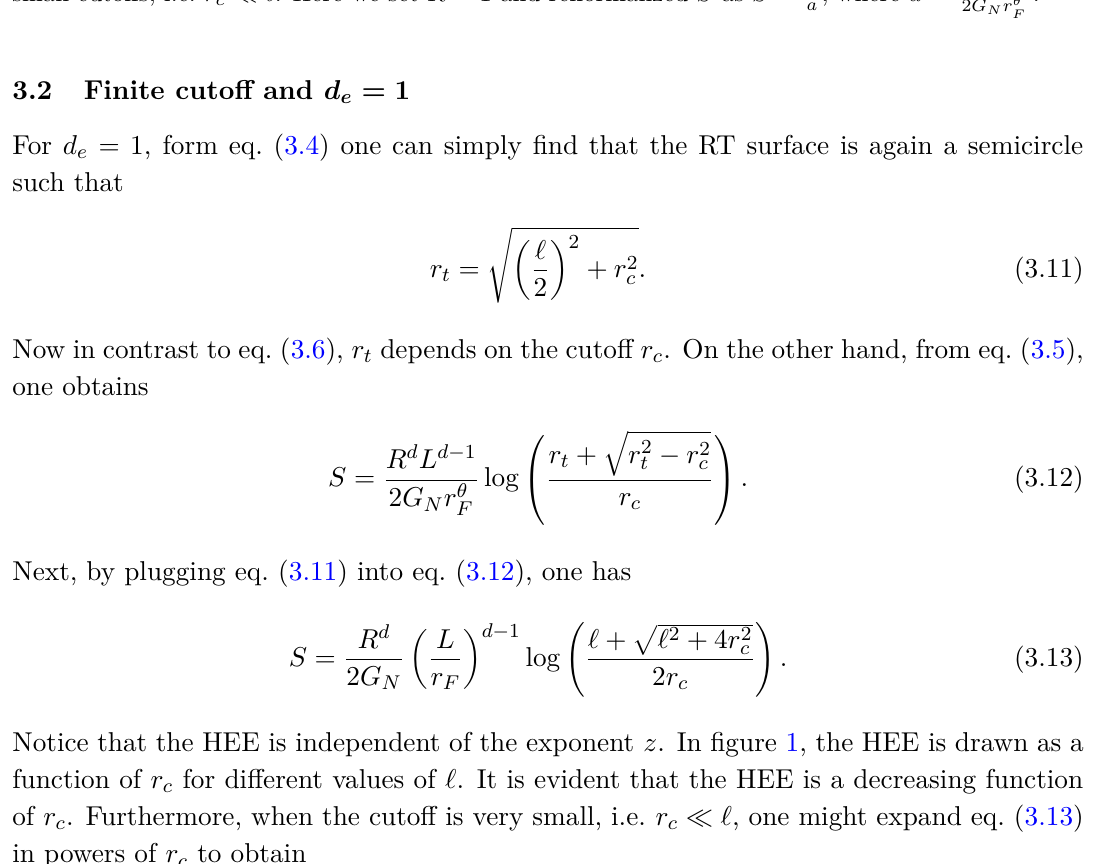
, where a = R d L d − 1 a 2 G N r θ F